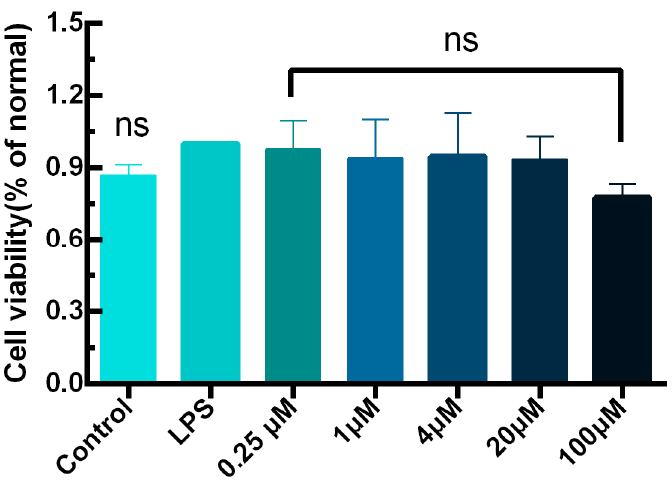
Figure 1. The viability assay of RAW264.7 cells was determined by MTT assay on different concentrations of compound 4d . Compared with the LPS group and the control group. The results are presented as the means ± SD of three different experiments. The difference was considered without statistically significance (ns).